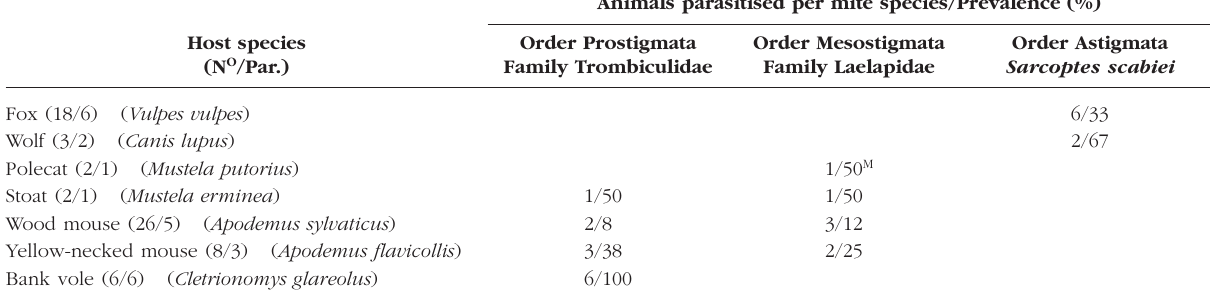
Host species (N O /Par.)